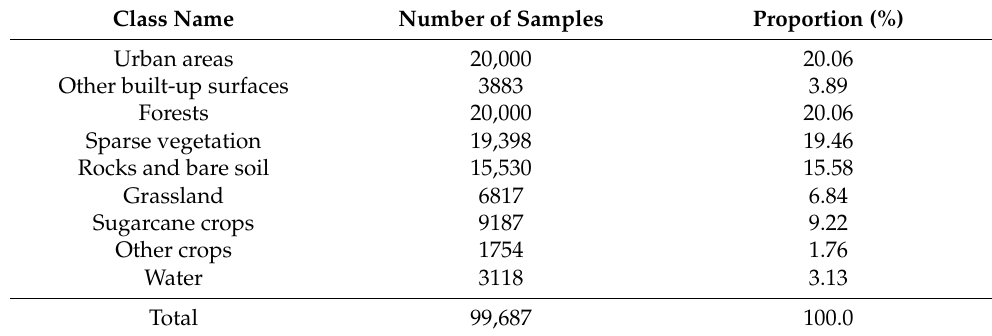
Figure 2. Study area of TiSeLaC: Reunion Island. Table 1. Sample Statistics of